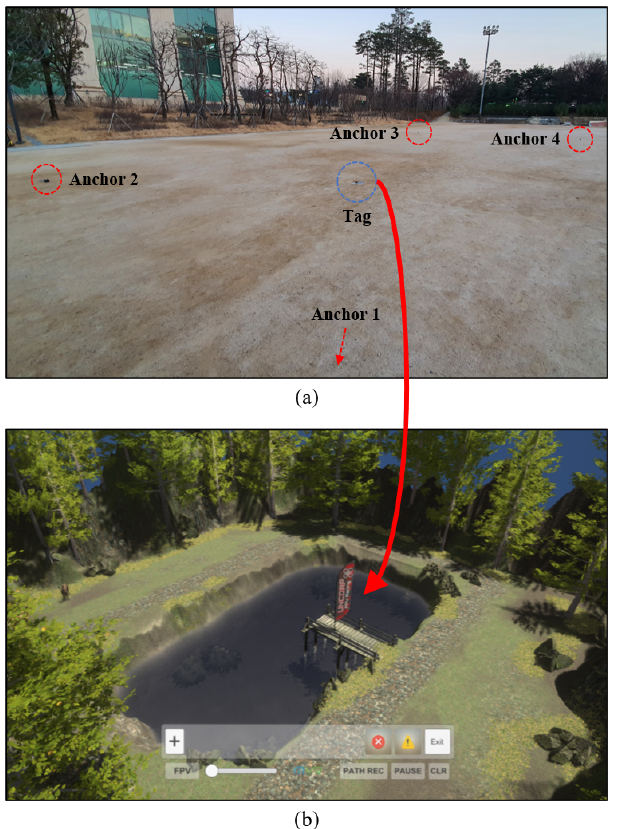
Figure 25. Actual space where the UWB sensor is placed and the reflected virtual flight space. ( a ) Real space with sensors ( b ) Virtual flight